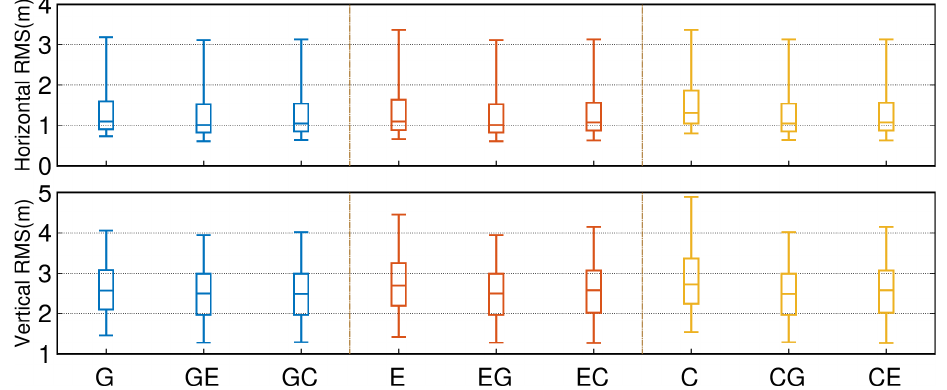
Figure 14. Boxplot of position accuracy of dual system with an elevation cut-off of 7°. Table 3. Gain of positioning accuracy of other systems to the current system.